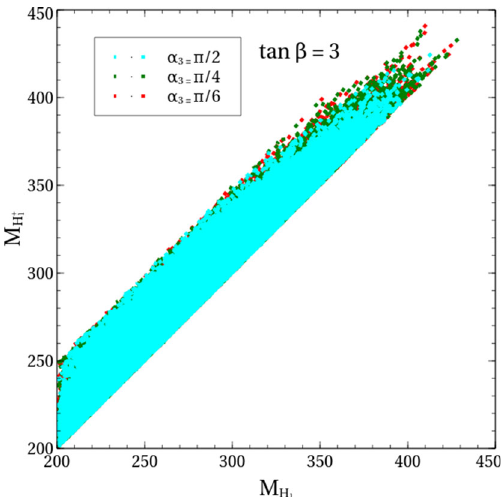
Fig. 1 Plot of the parameter space in M H π , π , π and tan β = 6 4 2